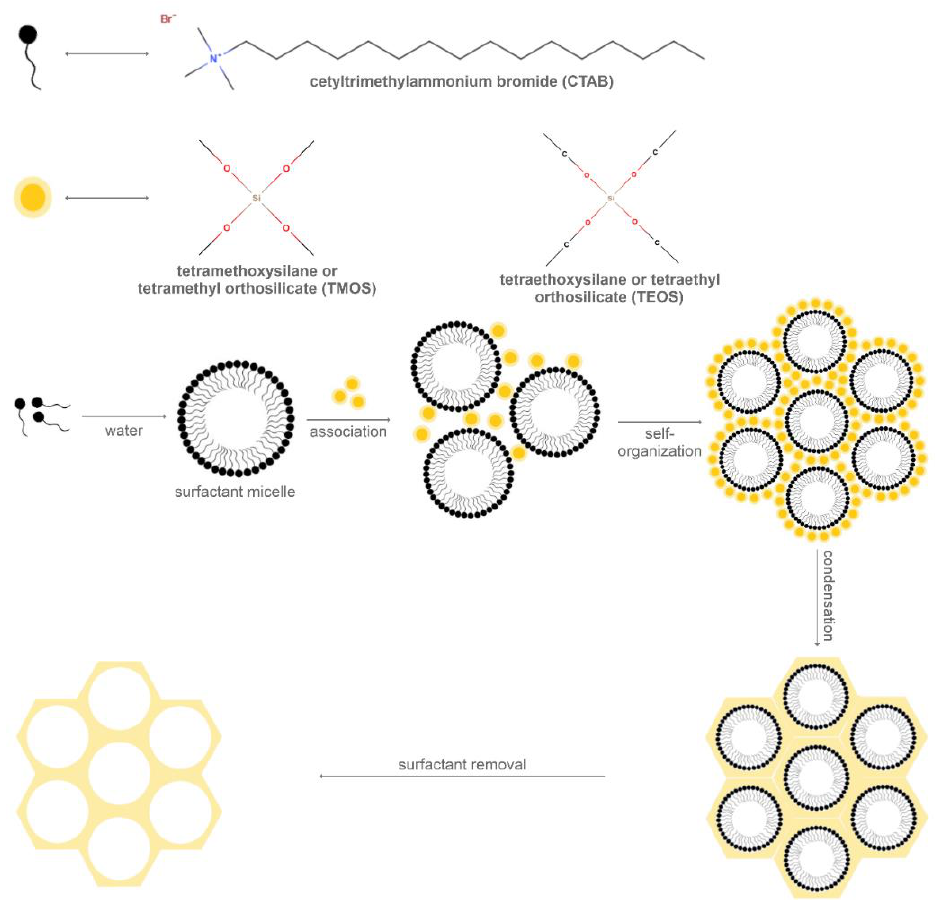
Figure 2. A schematic diagram of the processes involved in the synthesis of MCM-41.